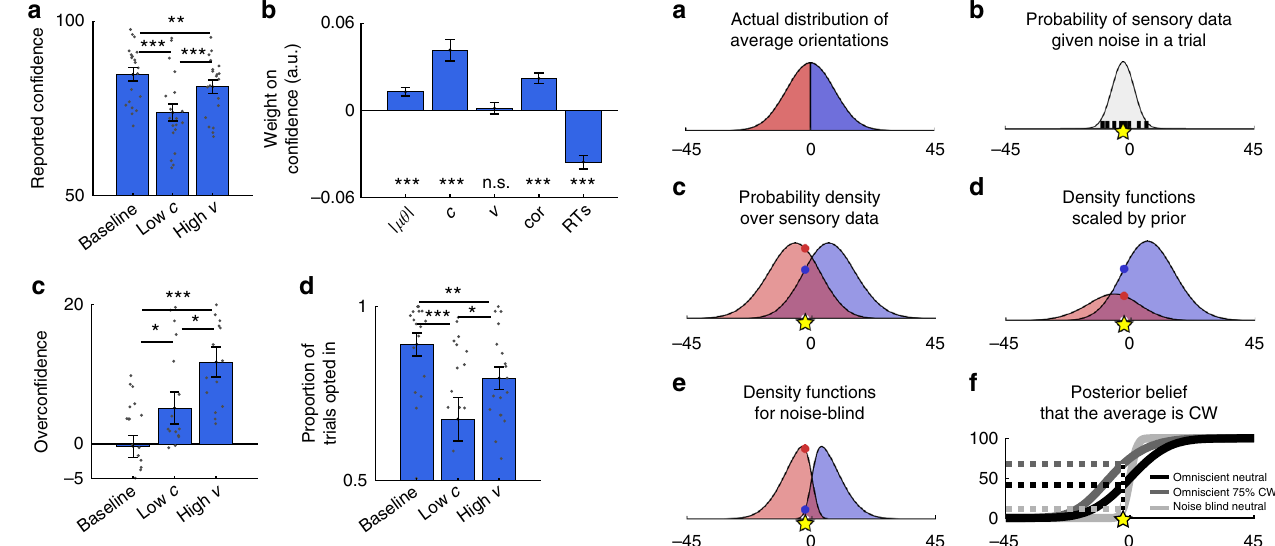
Fig. 3 Effects of contrast and variability on explicit and implicit markers of con fi dence. a Mean con fi dence in the baseline, reduced contrast (low- c ) and increased variability (high- v ) conditions. b Trial-by-trial con fi dence is not in fl uenced by variability ( v ) but is in fl uenced by the deviation of the average orientation from horizontal (| μθ |), contrast ( c ), choice accuracy (cor), which was included to account for error detection 32 , and response times (RTs). c Overcon fi dence, the difference between mean con fi dence and mean choice accuracy, is highest in the high- v condition. d Higher probability of making a choice (and not opting out) in the high- v condition compared to the low- c condition. See Supplementary Note 8 and Supplementary Fig. 8 for direct quanti fi cation of the accuracy gain foregone by participants in the high- v condition. a – d Data are represented as group mean ± SEM. For all panels, only neutral trials were used